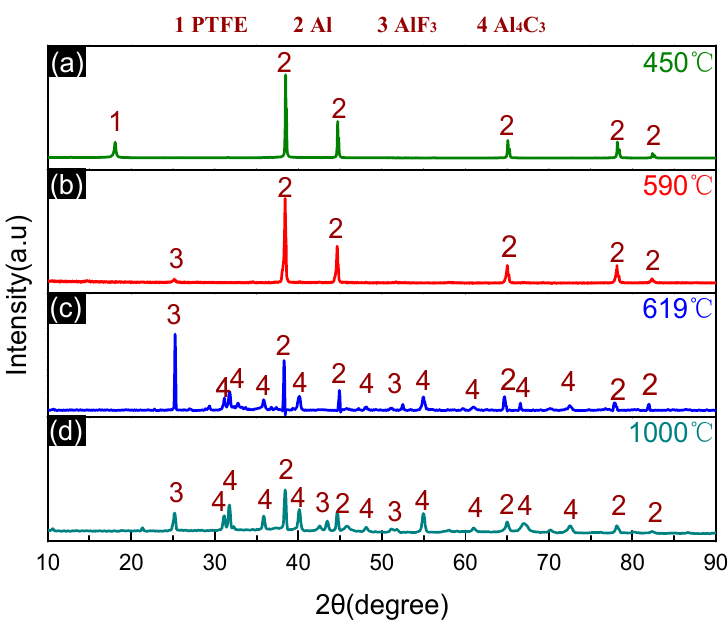
Figure 4. XRD patterns of PTFE/Al solid residues at different temperatures. ( a ) XRD patterns at 450 ◦ C; ( b ) XRD patterns at 590 ◦ C; ( c ) XRD patterns at 619 ◦ C; ( d ) XRD patterns at 1000 ◦ C. Table 2. Product composition in different temperature ranges during PTFE/Al (polytetrafluoroethylene/aluminum) thermal reactions. Temperature/ ◦ C <450 450–590 590–619 619–1000 Products